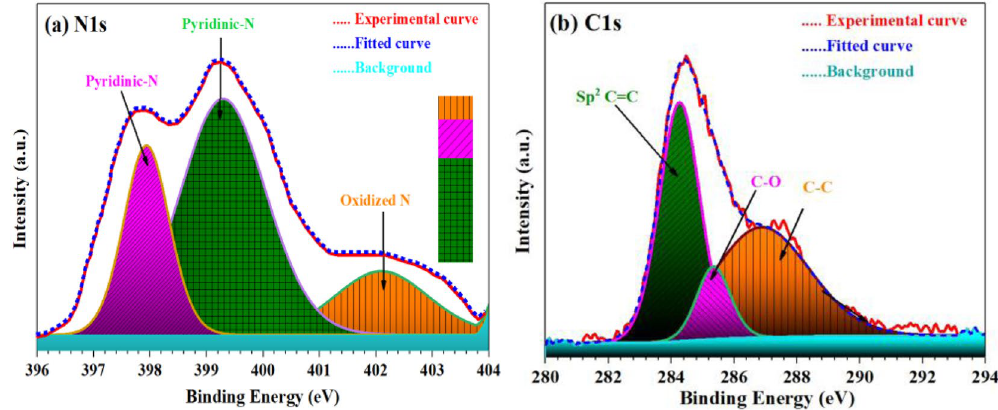
Figure 7. XPS spectra of Fe-doped C12A7:e − composite (x = 1), ( a ) N1s, and ( b )